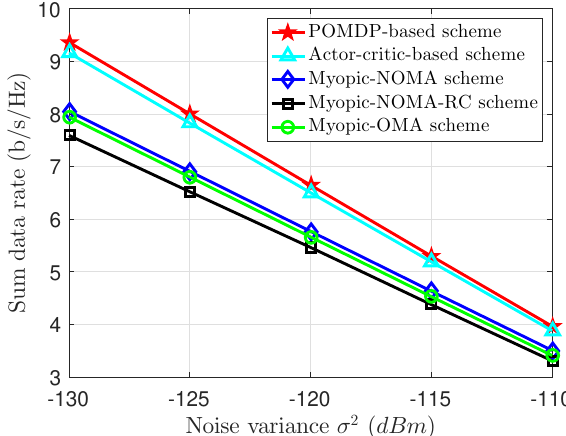
Figure 11. The sum data rate under different values of noise